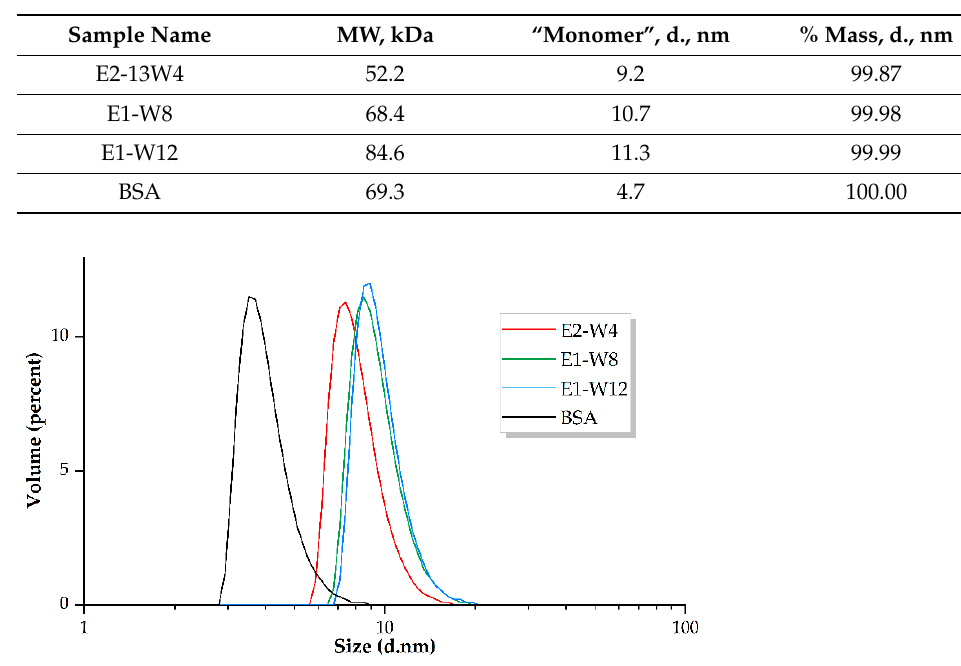
Figure 6. Size distribution of MBS proteins by volume measured by DLS. Red—E2-13W4; green— Size distribution of MBS proteins by volume measured by DLS. Red—E2-13W4; E1-W8; blue—E1-W12; black—BSA. green—E1-W8; blue—E1-W12;